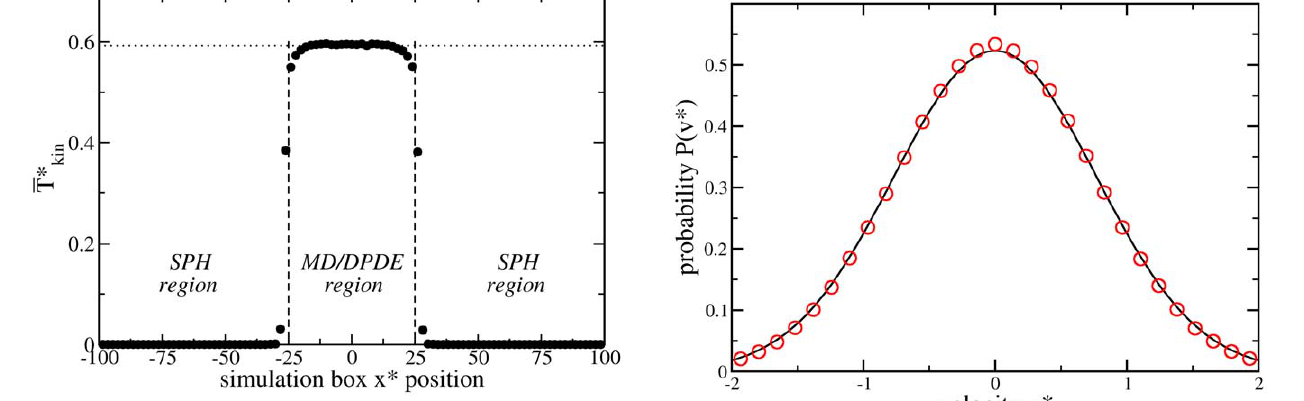
~ 0 : 593 Figure 4. Comparison of the Maxwell-Boltzmann velocity kin distribution, Eq. 14, (full line) with the measured results for the MD particles (symbols).